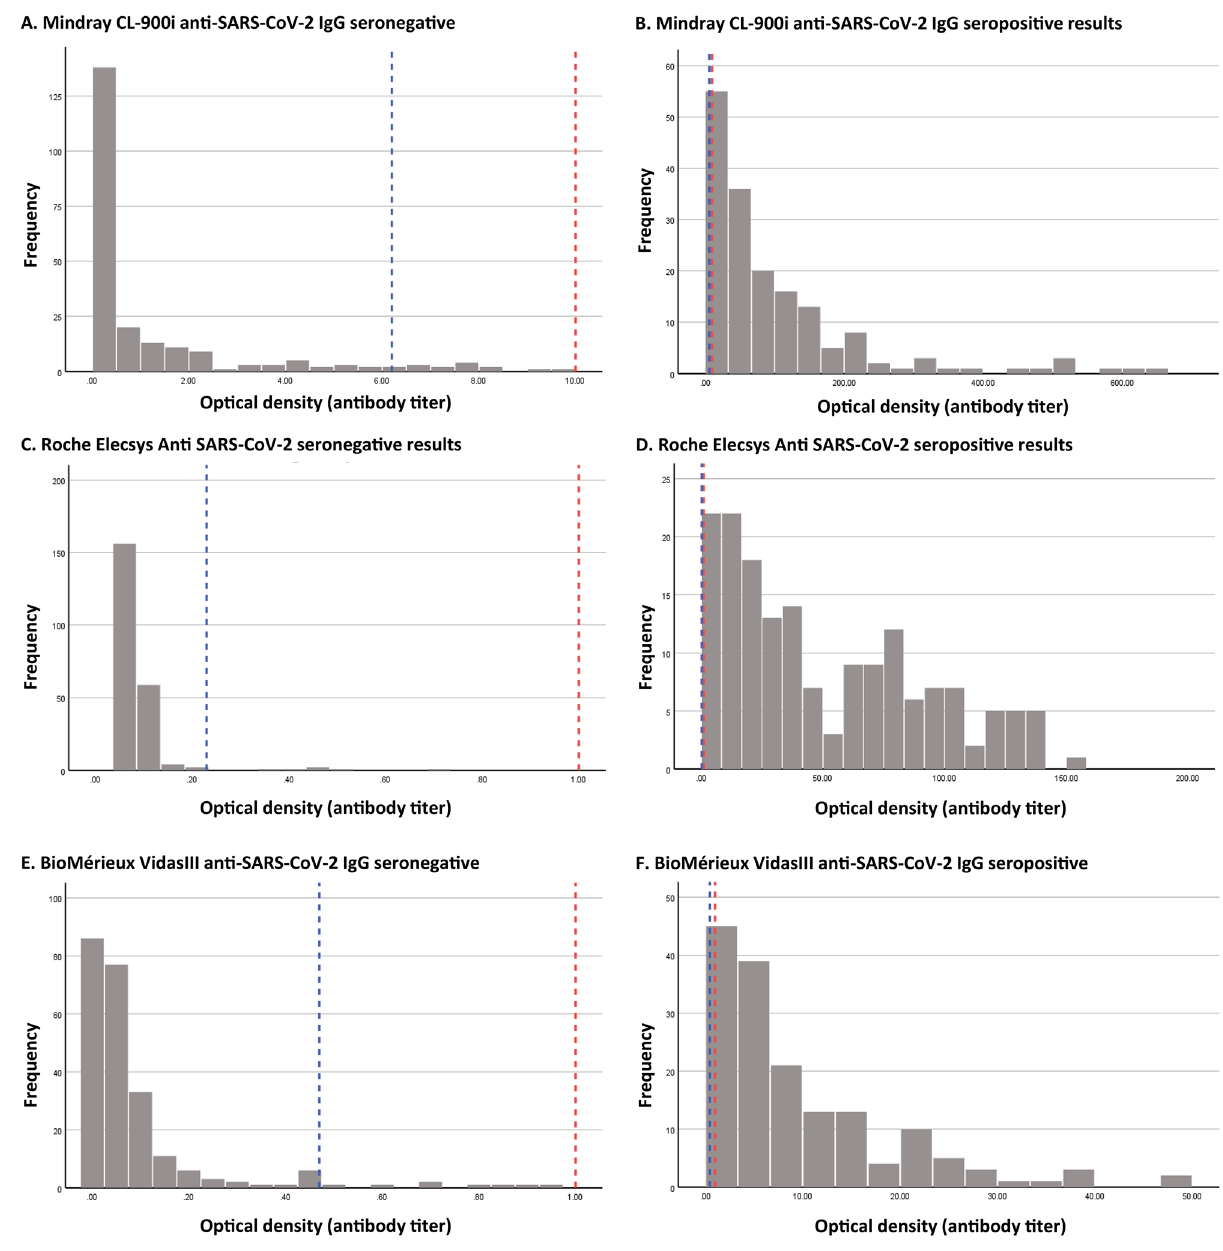
Figure 2. Distribution of the optical density values in those seronegative versus those seropositive for each assay. Red line indicates the manufacturer’s cut-off values. Blue line indicates the empirically determined optical density cut-off values as informed by the literature 26,27